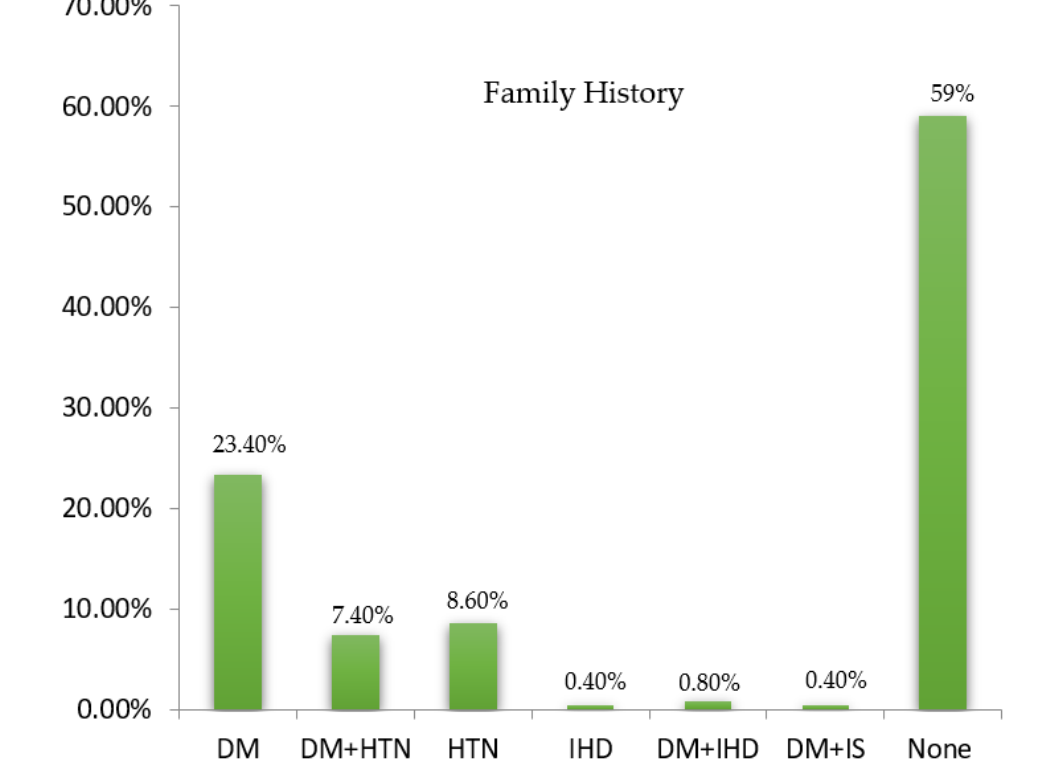
Figure 2. Socio-economic status of group subjects.